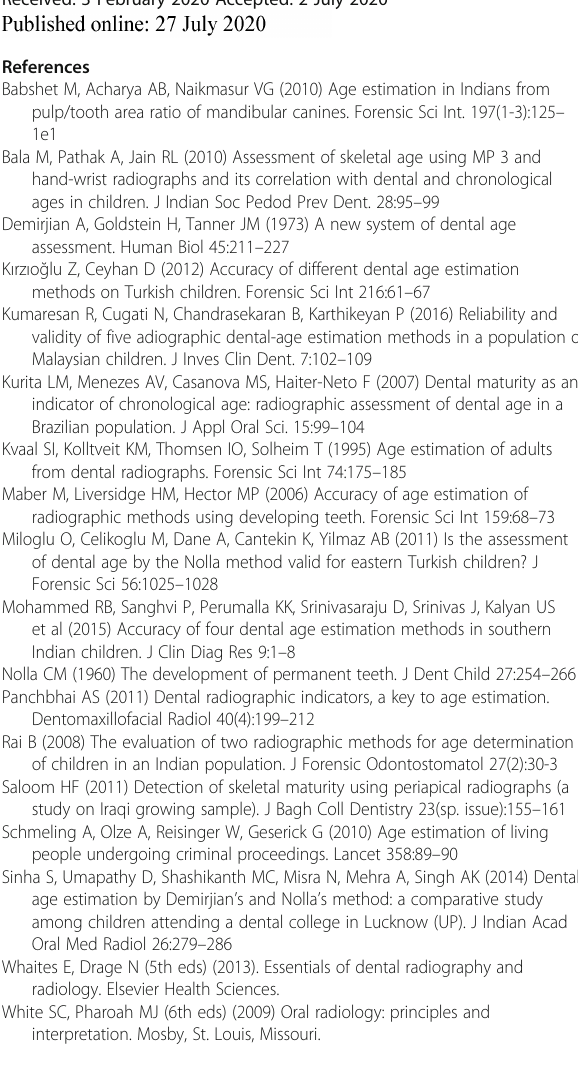
Table 4 Mean underestimation and overestimation in development amongst our subjects Subjects Mean underestimation in Mean overestimation in months (no. of subjects) months (no. of